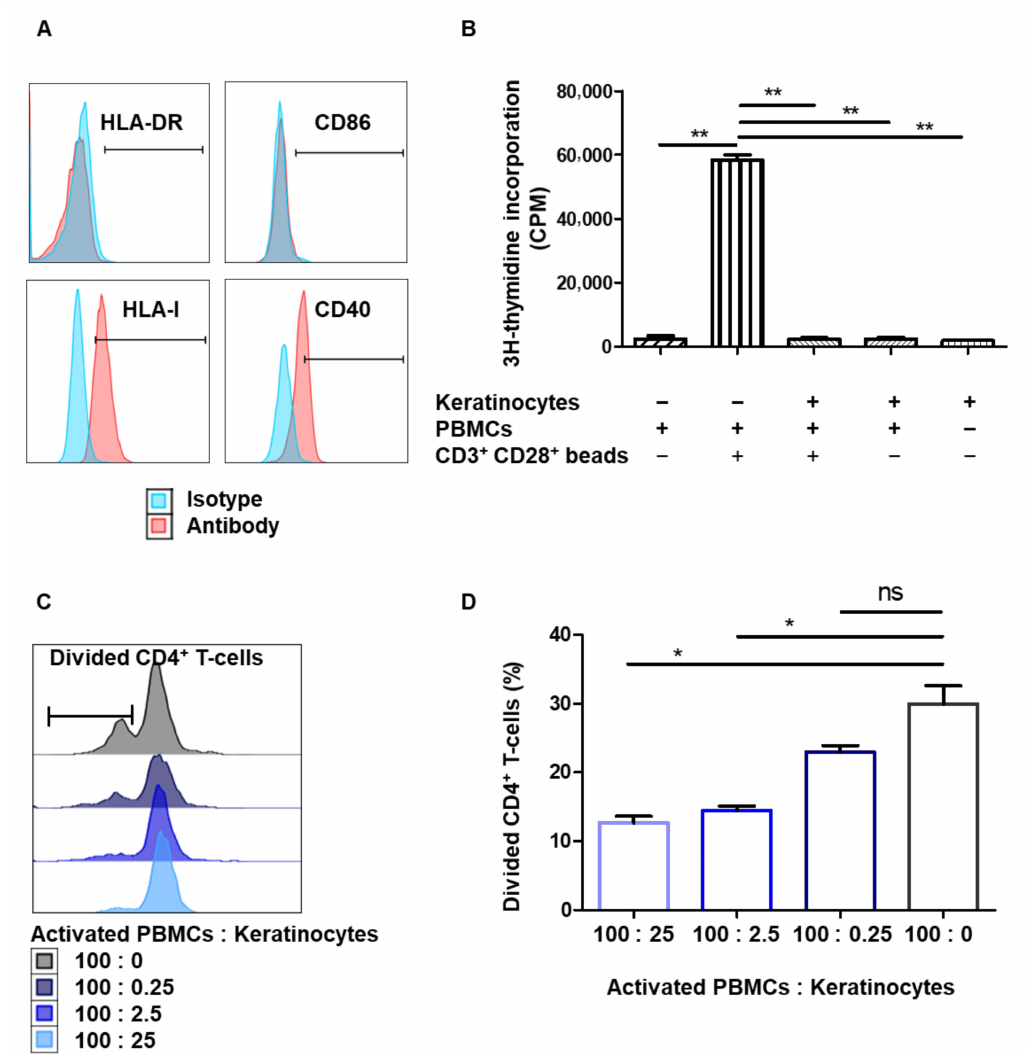
Figure 1. Amplified keratinocytes are hypoimmunogenic and limit CD4 + T-cell proliferation. ( A ) The keratinocytes